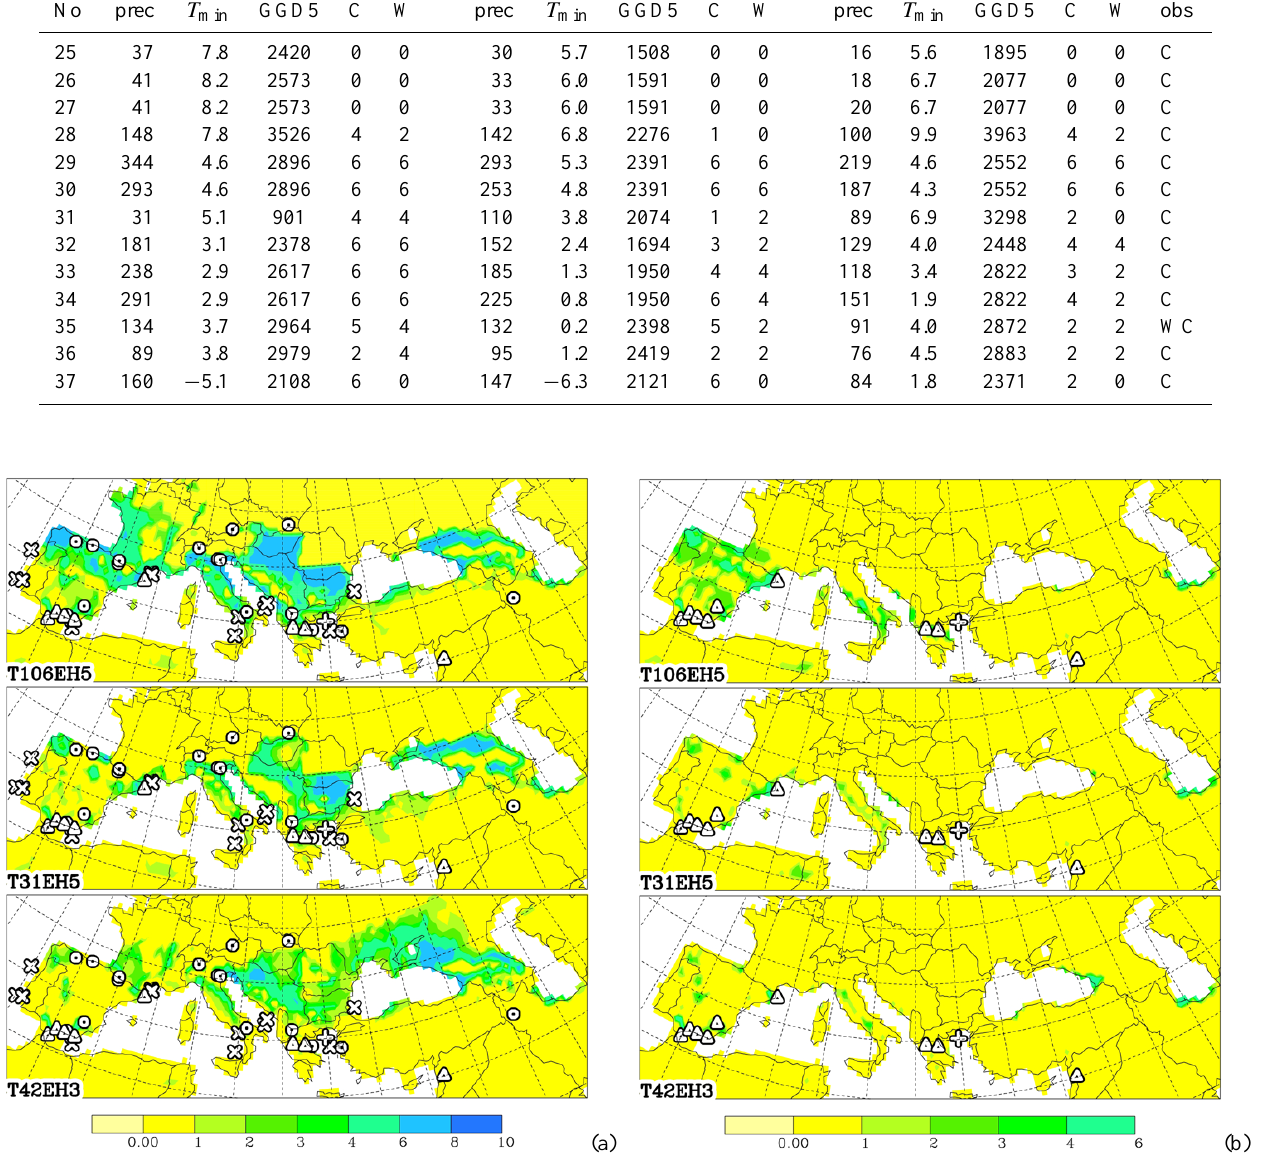
Fig. 10. Possible tree growth during the LGM in the different model simulations combining the summer precipitation, minimum temperature and growing degree days. For values of 1 and higher (green to blue colours) the minimum requirements for possible tree growth are met, higher values mean more summer precipitation and higher GDD5. Sites with observed tree growth during the LGM are indicated by markers as in Fig. 7. (a) Cold-tolerant trees, sites with warm-loving trees mostly have evidence of cold-tolerant trees as well. (b) Warm-loving